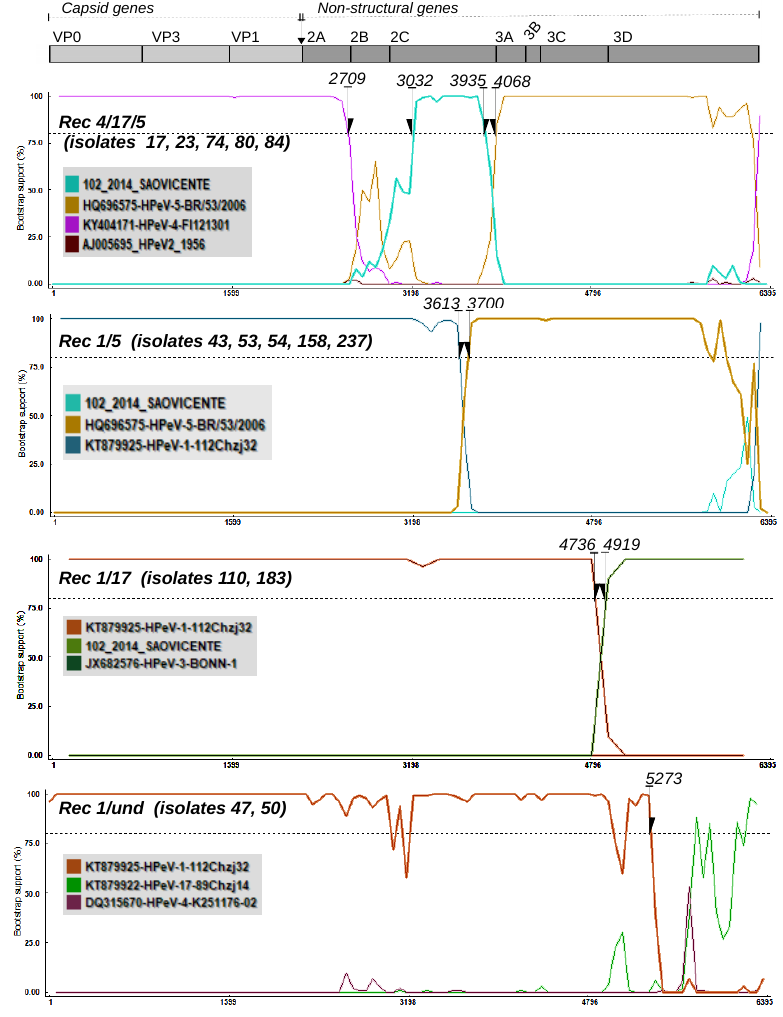
Figure 3. Recombination pattern of chimera strains of PeV-A from regions in northern Brazil. The bootscanning method was used to determine the parental genotypes that compose the recombinant PeV-A strain. Colored lines represent the probability (given in bootstrap value) of genomic regions belonging to a certain parental genotype. The x-axis represents the sequence length in base pairs (bp). The y-axis represents the statistical support (bootstrap) based on 500 replicates. In the upper region of the figure, a diagram shows the genome map of PeV-A. Each plotted line refers to a certain genotype (see the sequence code color in the gray panel). Each plot indicates the breakpoints in the polyprotein region of the following four categories of PeV-A recombinants: Rec1 / 5, Rec1 / 17, Rec1 / und, and Rec4 / 17 / 5. Isolates that belong to a certain recombinant category are listed within parenthesis. The evolutionary model (Felsenstein, 1984) plus the estimated transition / transversions (ts / tv = 2.7) were used. Window sizes of 100 to 650, stepping of 60–150 nt, as well as χ 2 correction, with p -values of 0.05 and 0.001, were utilized. All these analyses were performed using the RDP v4 software